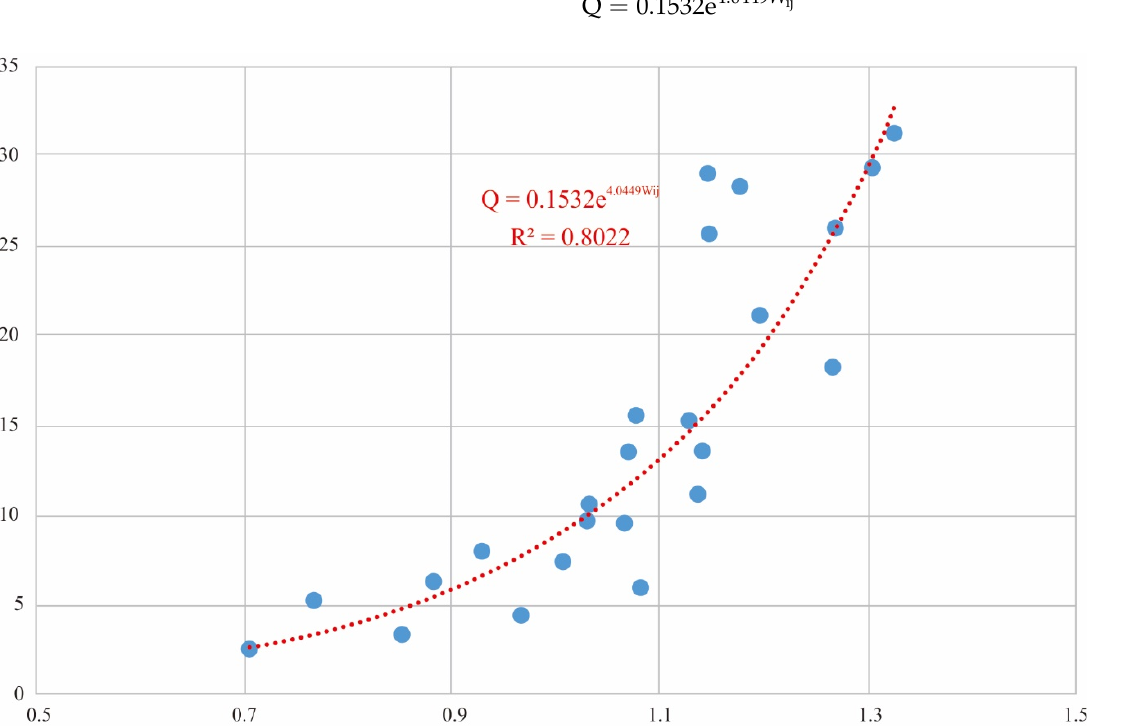
Figure 13. Well production vs. CPII.